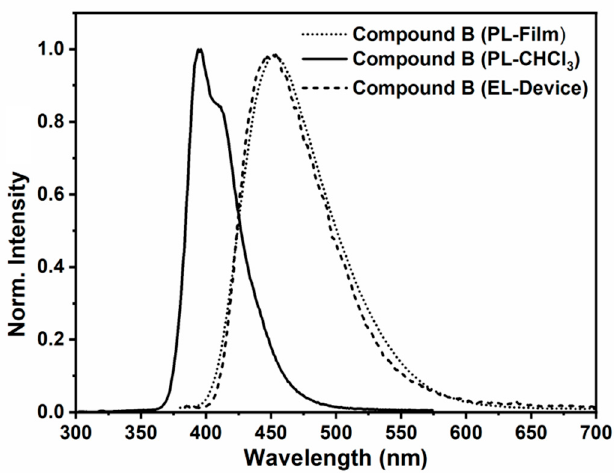
Figure 8. Normalized photoluminescence (PL) from solution and solid states, and electrolumines- cence from the OLED prototype recorded for compound B .